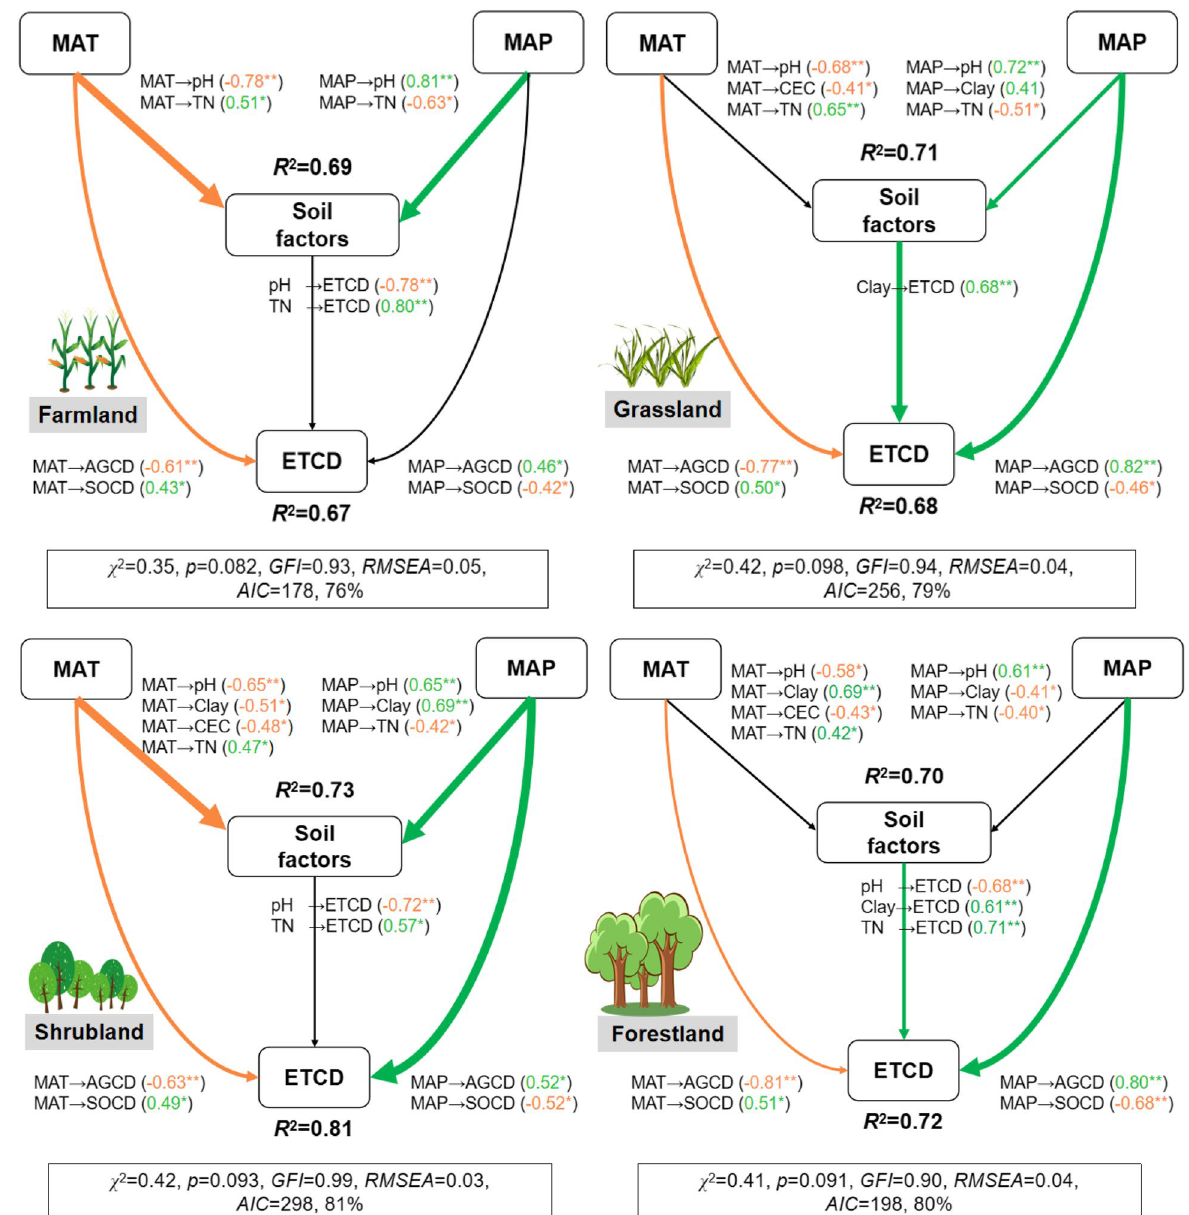
Fig. 8 Structural equation models (SEMs) depicting the multiple relations of ecosystem total carbon density (ETCD) with climate factors and soil properties, and the values are standardized coefficients of the models. The solid orange lines are the negative relationships, and the solid green lines are the positive relationships, and the solid black lines are no significant relationships, respectively. Arrows represent a directional influence of one variable upon another. The numbers beside the arrows are standardized coefficients. The thickness of the arrows is proportional to the magnitude of the standardized path coefficients or covariation coefficients. R 2 stands for variation interpreted by variables, which is calculated after 999 bootstraps, and the significant level is set at α 0.05, * p < 0.05, ** p < 0.01. AGCD: above-ground carbon density; BGCD: above-ground carbon = density; SOCD: soil organic carbon density; ETCD: ecosystem total carbon density; MAP: mean annual precipitation; MAT: mean annual